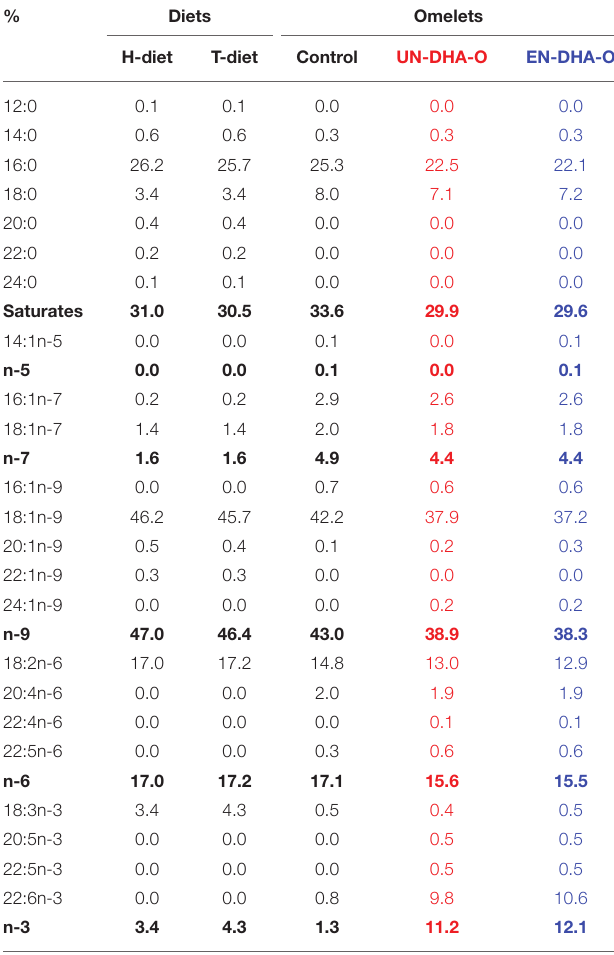
TABLE 2 | The fatty acid composition of the diets and the